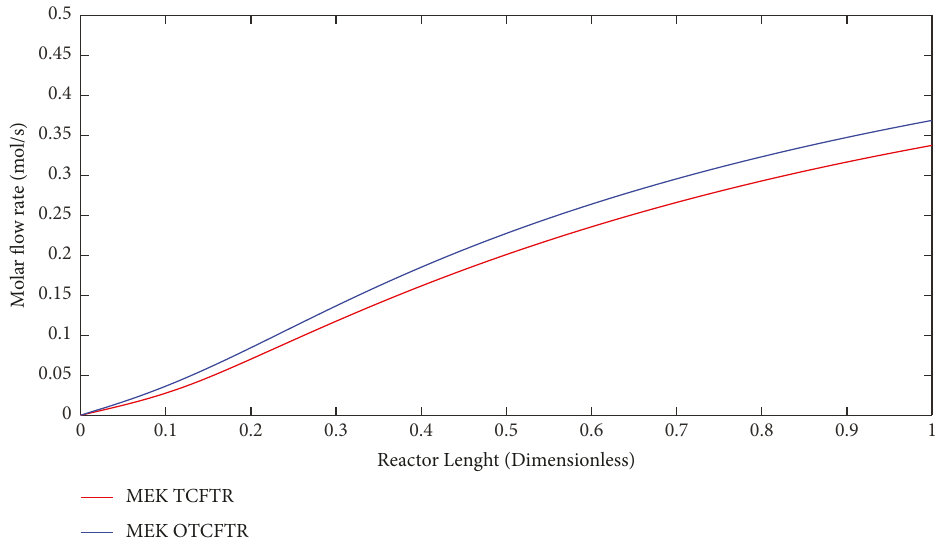
Figure 15: Comparison of the molar flow rate of MEK in the endothermic part of the reactor for TCFTR and